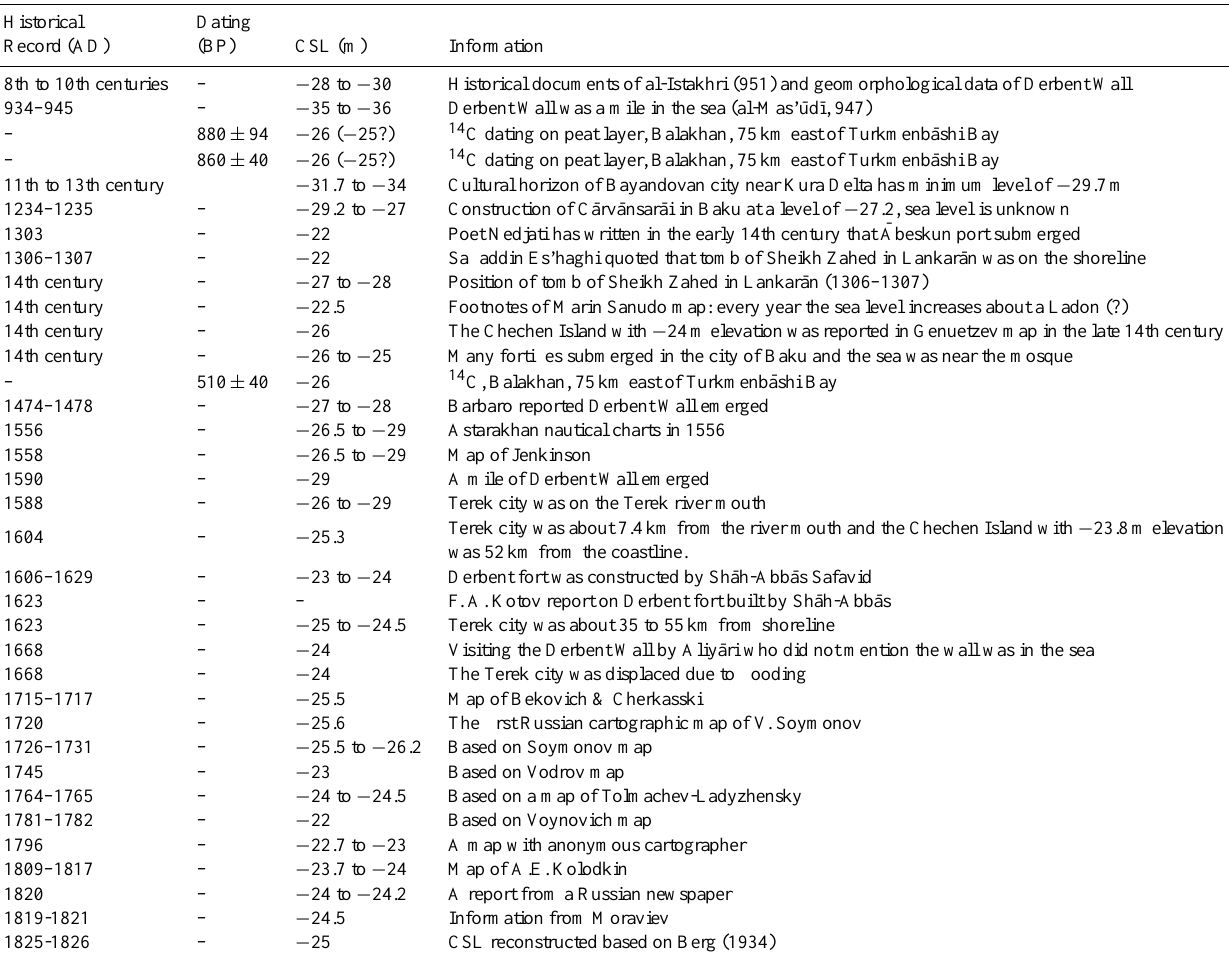
Table 4. Dates, type of historical and geological evidence and the Caspian sea-level summary from the tenth to nineteenth centuries (Varushchenko et al.,